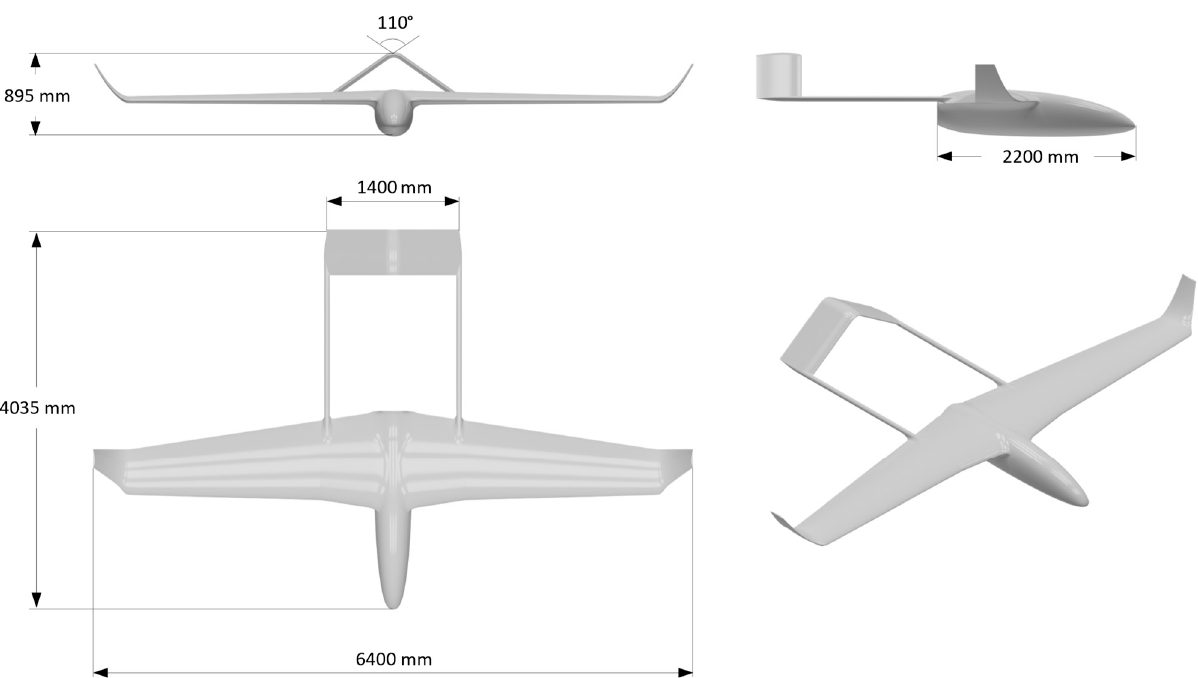
Figure 2. The HCUAV RX-1 dimensions.